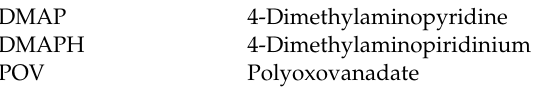
Figure S1: TGA and DTA for 1 , Figure S2: FT-IR spectra of 1 , as prepared sample, and the residue at different temperatures, Figure S3: TGA and DTA for 2 , Figure S4: FT-IR spectra of 2 , as newly synthesized sample, and the residue at different